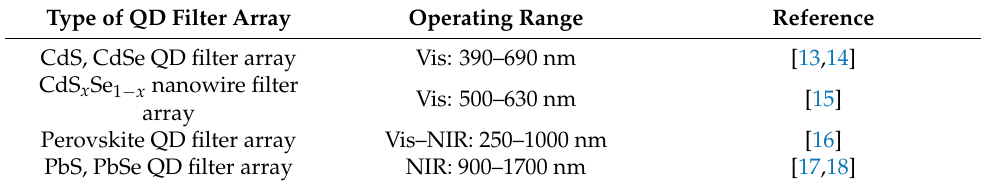
Table 1. Existing filter films and their working